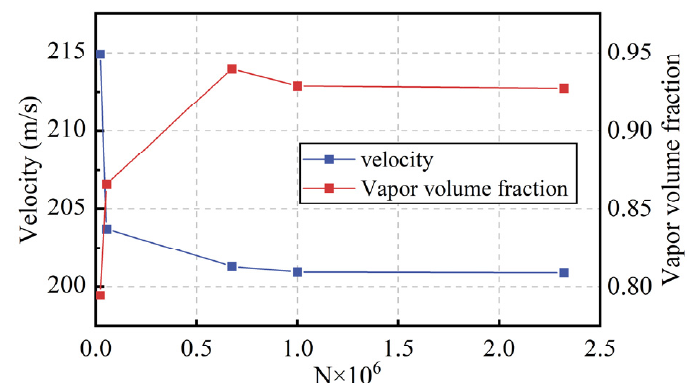
Figure 5. y + in CFD postprocessing. Figure 5. 𝑦 (cid:2878) in CFD postprocessing.